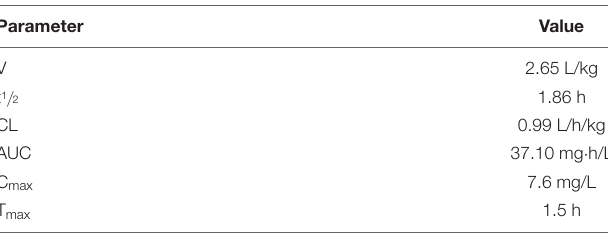
TABLE 1 | Non-compartmental parameter estimates for finafloxacin in male A/J mice, following administration of finafloxacin by the oral route (37.5